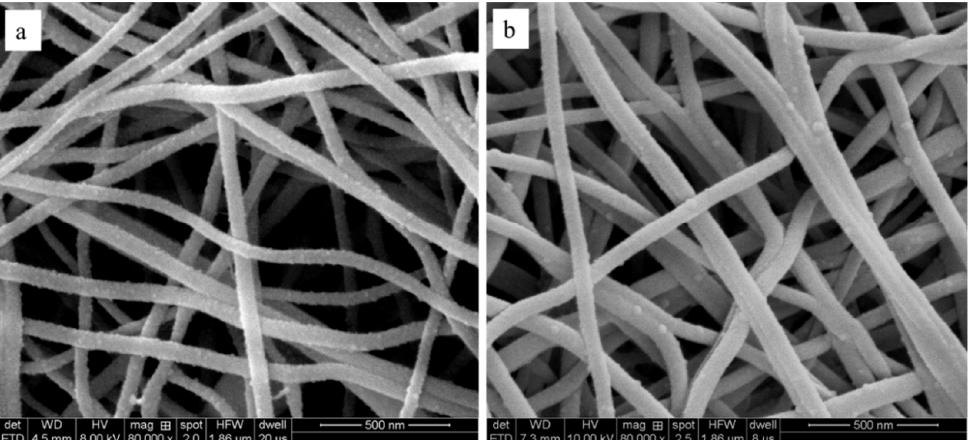
Figure 2. SEM images of the reduced catalysts prepared with different solvents: ( a ) H 2 O/C 2 H 5 OH; ( b ) DMF/C 2 H 5 OH.